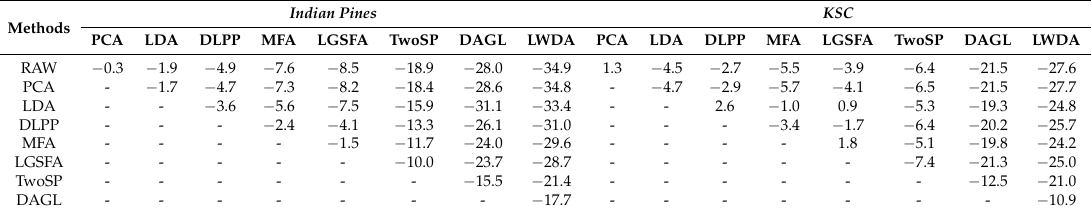
Table 4. McNemar test of different methods on the Indian Pines and KSC